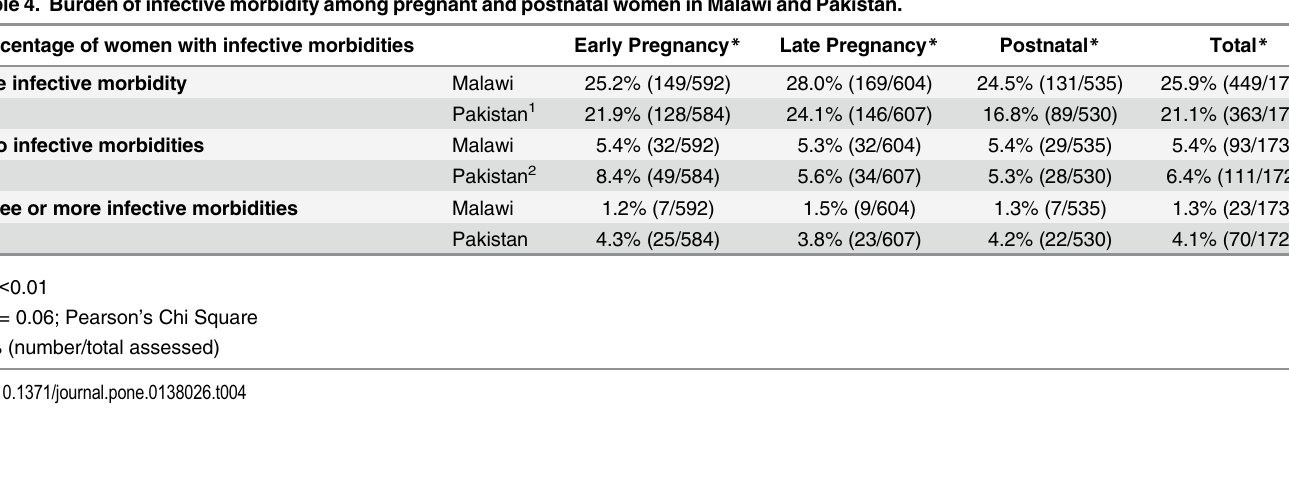
centages were significantly different between pregnancy and postnatal periods: 34.6%, 33.4% and 26.2%, p = 0.005. The majority of women had just one identified infective morbidity, with difference between stage of pregnancy and burden of infective morbidity. However, in Paki- stan, significant differences were noted across stage of pregnancy among women who report only one infective morbidity with less morbidity reported in the postnatal compared to the